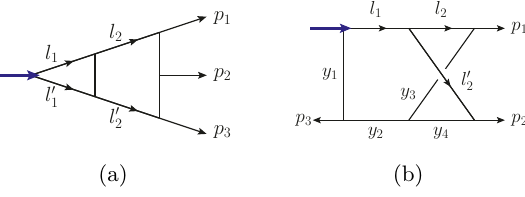
Figure 8. Symmetry constraint examples for the two-loop form factor of tr( φ 2 )